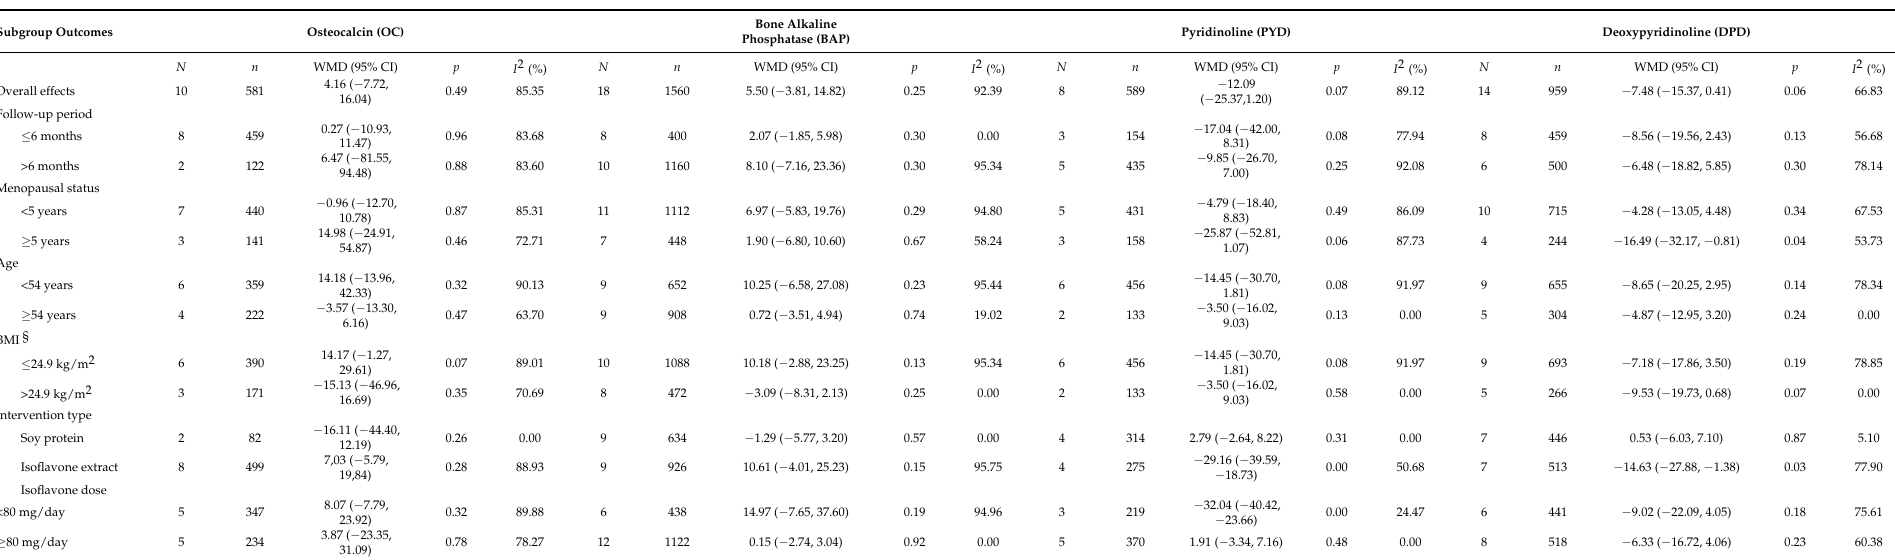
Table 2. Pooled estimates of treatment effect on biochemical bone turn-over markers in subgroups of